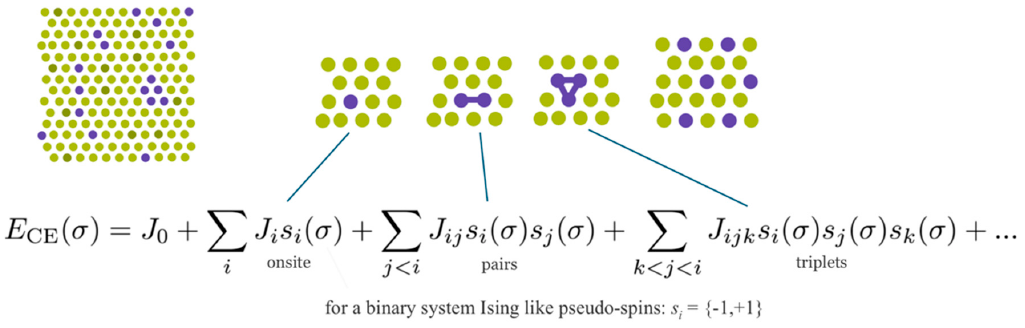
Figure 11. Schematic description of the cluster expansion method.